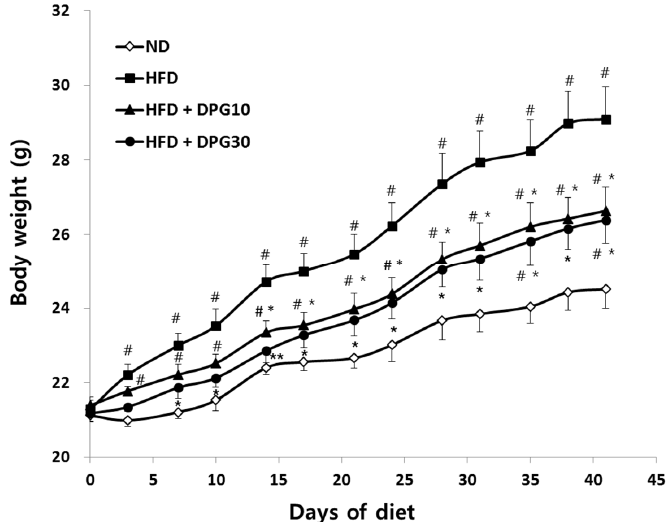
Figure 2. Effect of DPG10 and DPG30 on body weight in high fat-diet (HFD)-induced obese mice. Results are expressed as the mean ± SE ( n = 12 − 15). # p < 0.05 compared with ND (normal diet) group, * p < 0.05, ** p < 0.01 compared with HFD group.